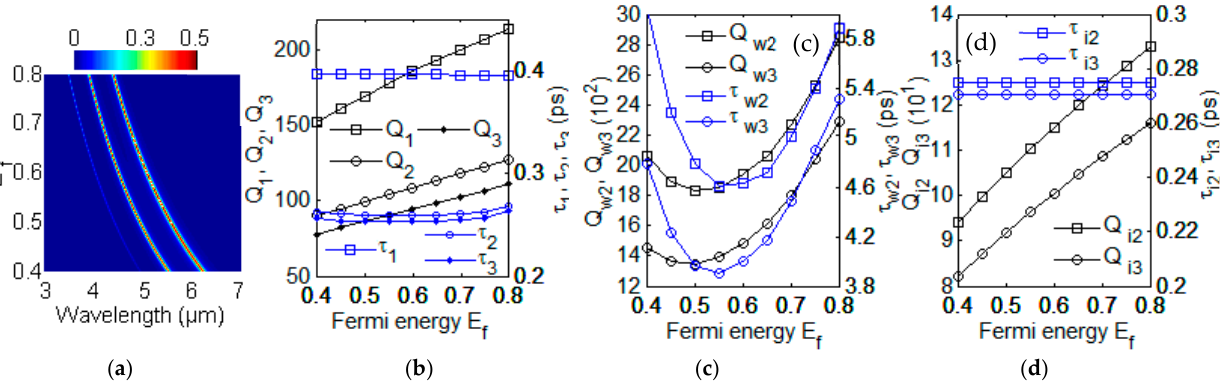
Figure 3. ( a ) The evolution of optical absorption spectra with different Fermi energy with using FDTD simulation. ( b ) Q 1 , Q 2 , Q 3 and τ 1 , τ 2 , τ 3 with different Fermi energy E f . ( c ) Q w2 , Q w3 and τ w2 , τ w3 with different Fermi energy E f . ( d ) Q i2 , Q i3 and τ i2 , τ i3 with different Fermi energy E f . For graphene plasmonic-photonic structure at m-th GSP mode (m = 1, 2, 3), the quality factor Q m and lifetime τ m with different Fermi energy E f are shown in Figure 3b . With the fixed value μ = 1 m 2 /(V·s) and n 1 = 1, the Q m increase as the increasing of Fermi energy E f in Figure 3b. The τ m has little change as the E f increasing from 0.40 eV to 0.70 eV. The τ 2 and